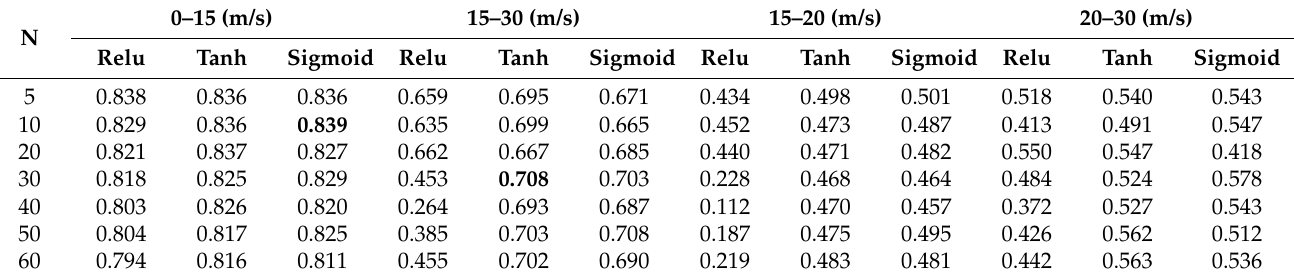
Table 6. Rs of the ANN models.